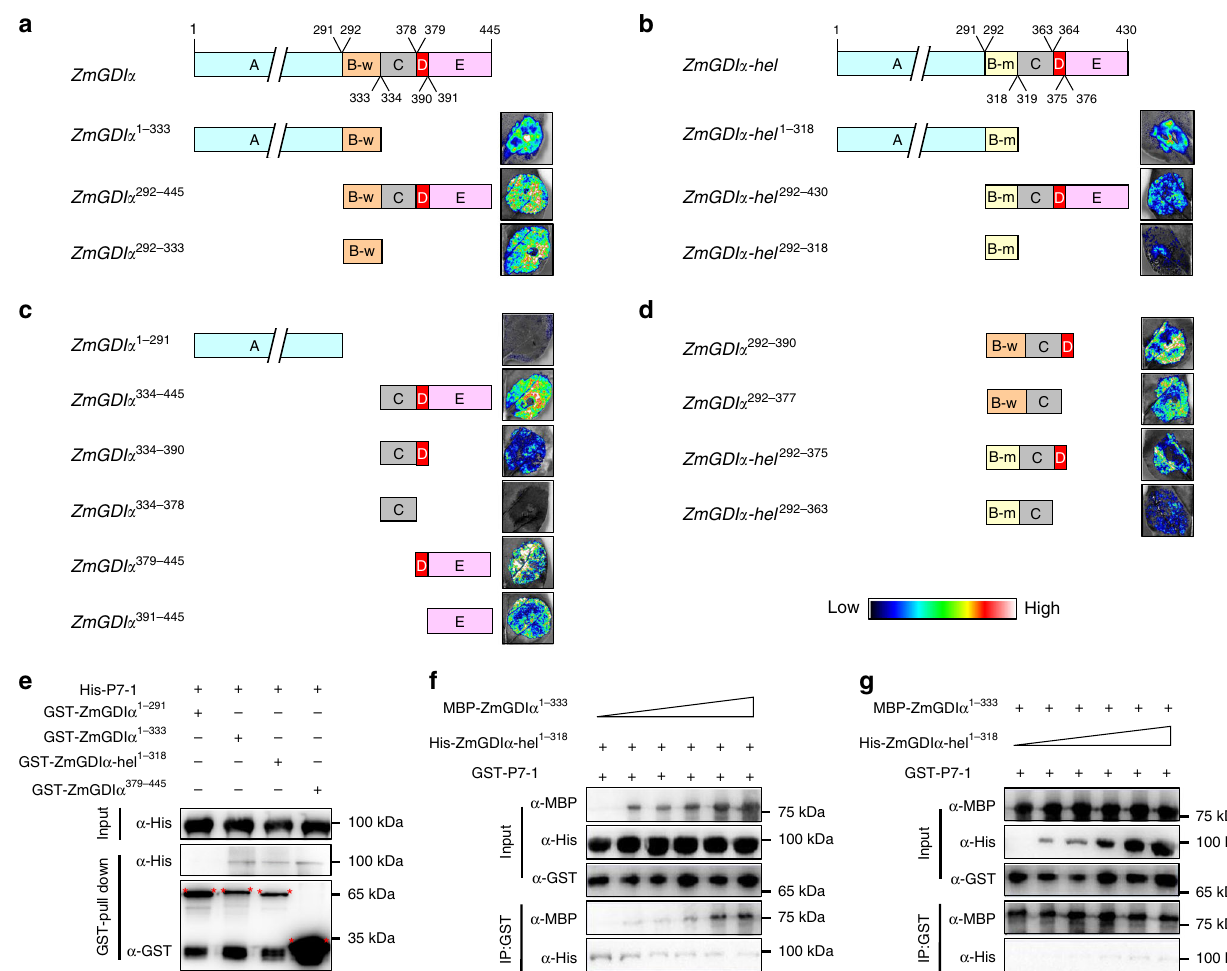
Fig. 5 Searching for viral P7-1-binding regions in ZmGDI α and ZmGDI α -hel. To reveal the P7-1-binding regions, ZmGDI α was divided into multiple segments, marked with different colors (the numerals above/under segments are amino-acid numbers counted starting from the initiation codon): A: ZmGDI α 1 – 291 , light green rectangle; B-w: ZmGDI α 292 – 333 , orange rectangle; C: ZmGDI α 334 – 378 , gray rectangle; D: ZmGDI α 379 – 390 , red rectangle; E: ZmGDI α 391 – 445 , pink rectangle. The B-w counterpart in ZmGDI α -hel is denoted as B-m: ZmGDI α -hel 292 – 318 , light yellow rectangle. Images at right are from split luciferase complementation assays in which various cLUC -tagged ZmGDI α or ZmGDI α -hel gene segments were co-expressed with the nLUC -tagged viral S7-1 in N. benthamiana leaves. a Viral P7-1 interacted with the exon-10-encoded residues in ZmGDI α . b Viral P7-1 also interacted with the helitron - derived exon-10-encoded residues in ZmGDI α -hel. c Viral P7-1 bound to theC-terminal 67 residues. d The ZmGDI α 334 – 378 fragment has no in fl uence on its fl anking fragments regarding to their interactions with P7-1. The high-low reference bar shows fl uorescence signals, ranging from high (left, white with red) to low (right, blue). e GST pull-down assay in vitro. Pull-down of the His-P7-1 fusion protein is detected for ZmGDI α 1 – 333 , ZmGDI α -hel 1 – 318 , and ZmGDI α 379 – 445 , but not ZmGDI α 1 – 291 , by immunoblotting with an anti-His antibody. f Competitive protein-binding assay with a fi xed amount of His- ZmGDI α -hel 1 – 318 (200 μ g). The interacting proteins were pulled down with anti-GST agarose resin and detected by immunoblotting with either MBP (for MBP-ZmGDI α 1 – 333 ) or His (for His-ZmGDI α -hel 1 – 318 ) antibody. g Competitive protein-binding assay with a fi xed amount of MBP-ZmGDI α 1 – 333 (200 μ g). The interacting proteins were pulled down with anti-GST agarose resin and detected by immunoblotting with either MBP (for MBP-ZmGDI α 1 – 333 ) or His (for His-ZmGDI α -hel 1 – 318 ) antibody. Each experiment was repeated three or more times independently, with the similar results. Source data are provided as a Source Data fi